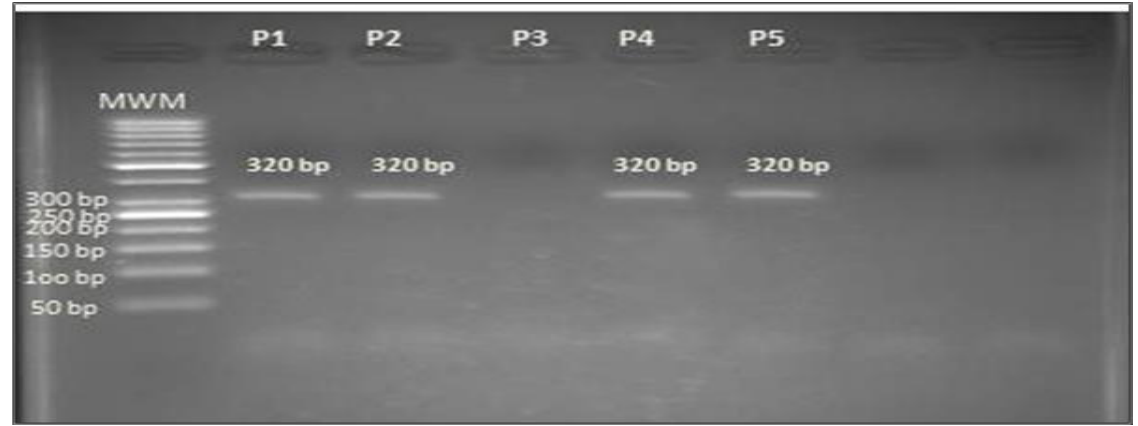
Figure 3. a) MIC measurement by E test method for P. aeruginosa strain that was resistant to colistin (MIC; 12 µg/mL), b) Another P.aeruginosa isolate resistant to colistin (MIC; 24 µg/mL)